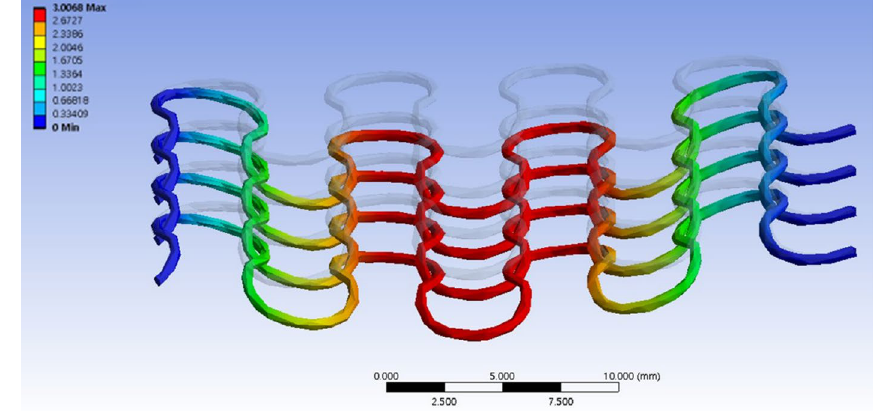
Fig.2 Finite elements analysis of shape memory textile actuator using ANSYS